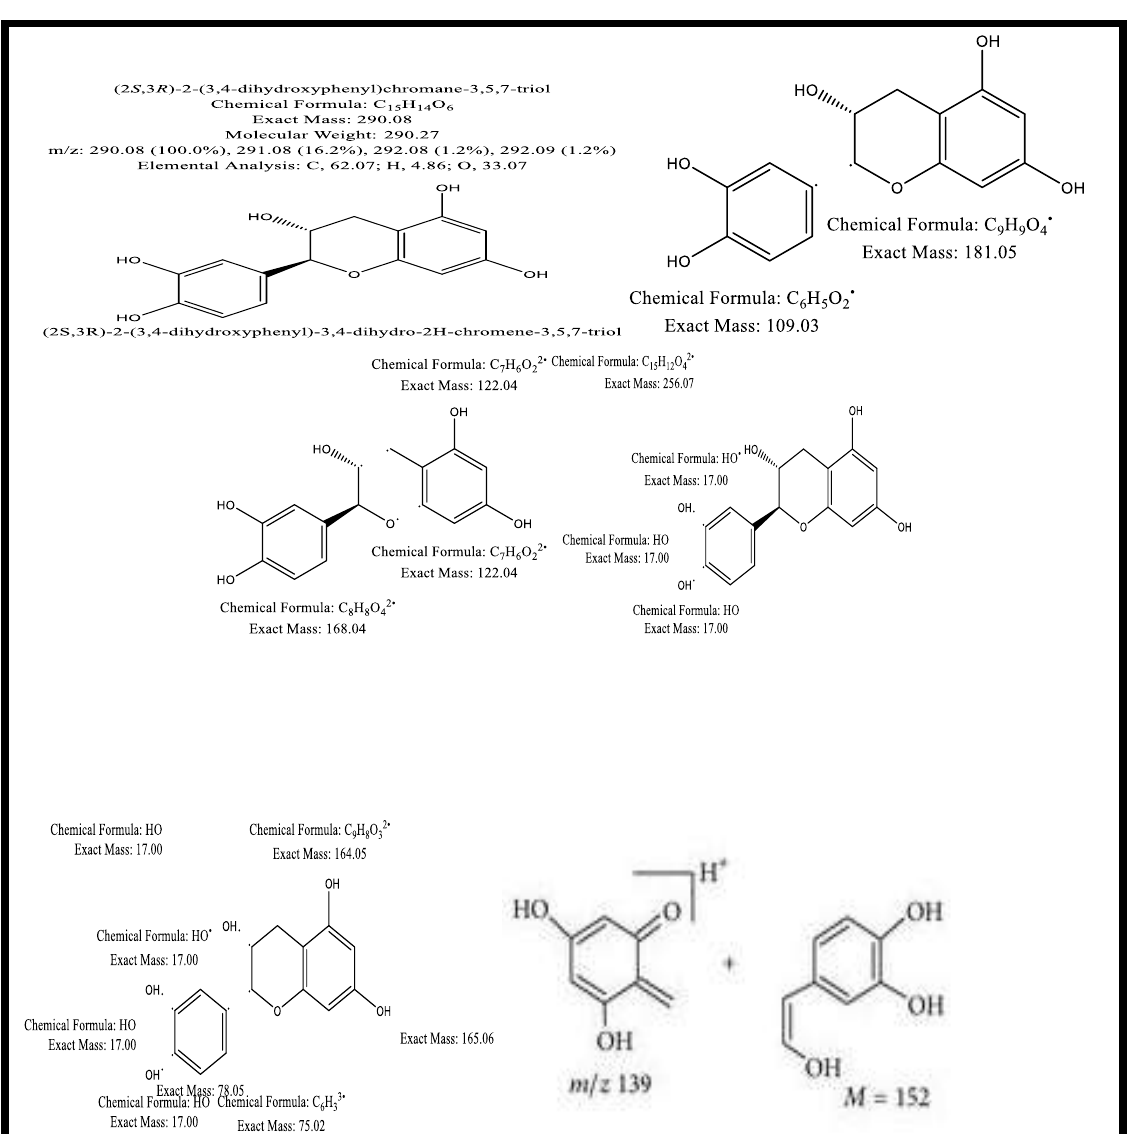
Figure 12.Mass Fragment of Compound II catechin catechin =290.27 g/mol M\Z=